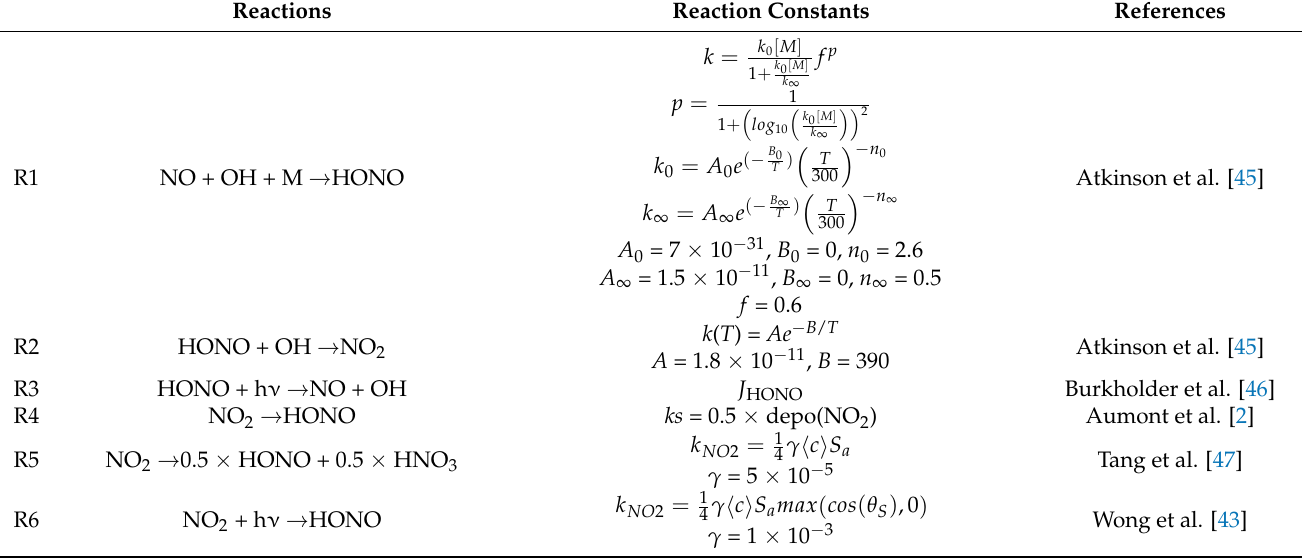
Table 1. List of reactions involving HONO included in the CHIMERE